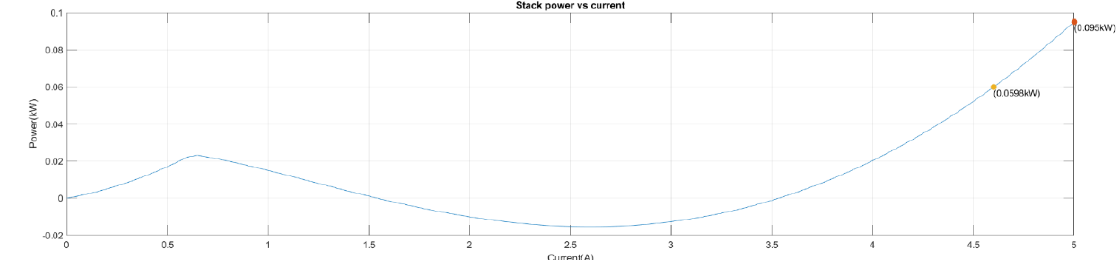
Figure 19. Power curve simulation of the selected fuel cell.